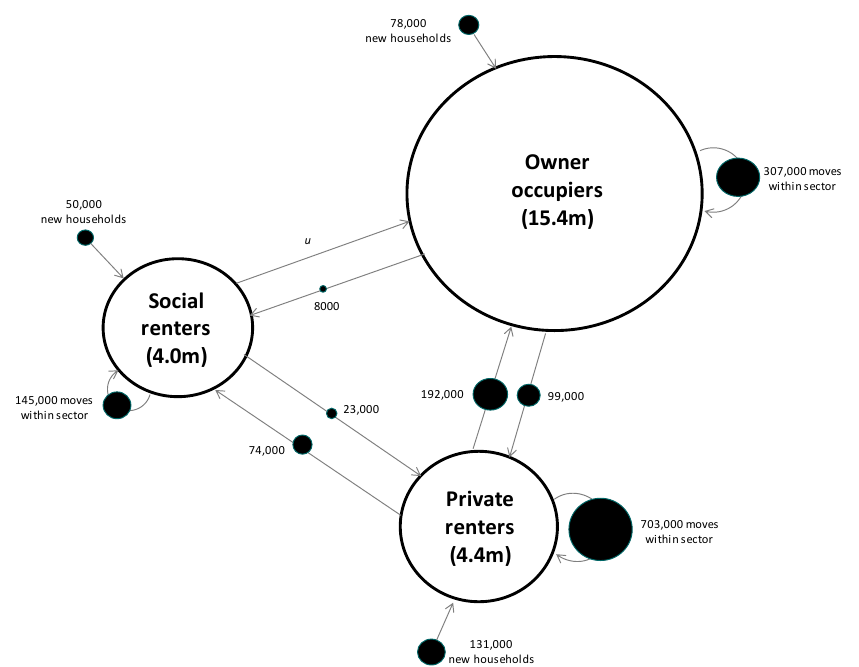
Figure 3. Household moves, by tenure (EHS data), 2019–2020. Note: The number of households, moved out or moved in within each housing tenure in 12 months is reflected by appropriate arrows and numbers. The total number of households in a given housing tenure (for the survey period covering 2019–2020) is shown in the circles. Figure 3 addresses only those households that changed housing tenure during the period under consideration ( u indicates that the sample size is too small to make a reliable